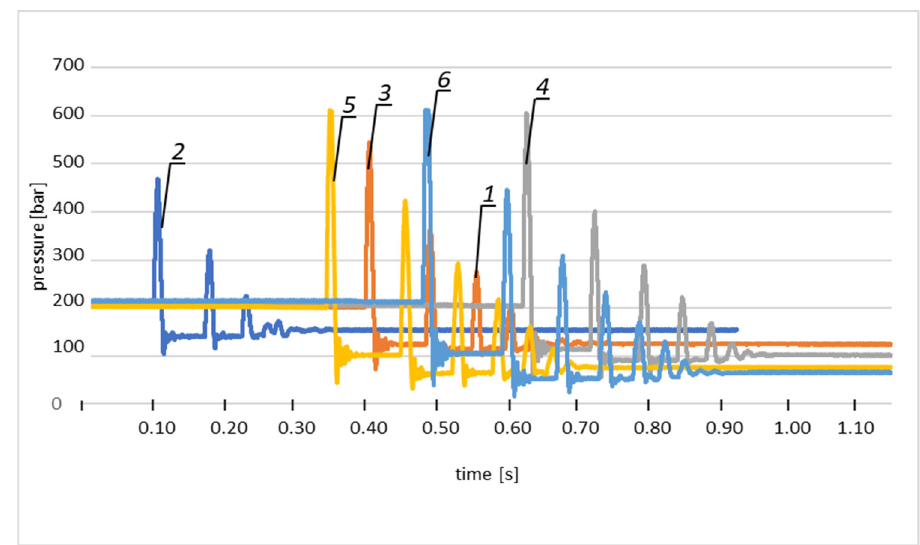
Figure 10. Opening of the safety valve during tests for different heights of impact mass drop, where: ( 1 ) drop height 20 cm, ( 2 ) drop height 30 cm, ( 3 ) drop height 40 cm, ( 4 ) drop height 50 cm, ( 5 ) drop height 60 cm, ( 6 ) drop height 70 cm.